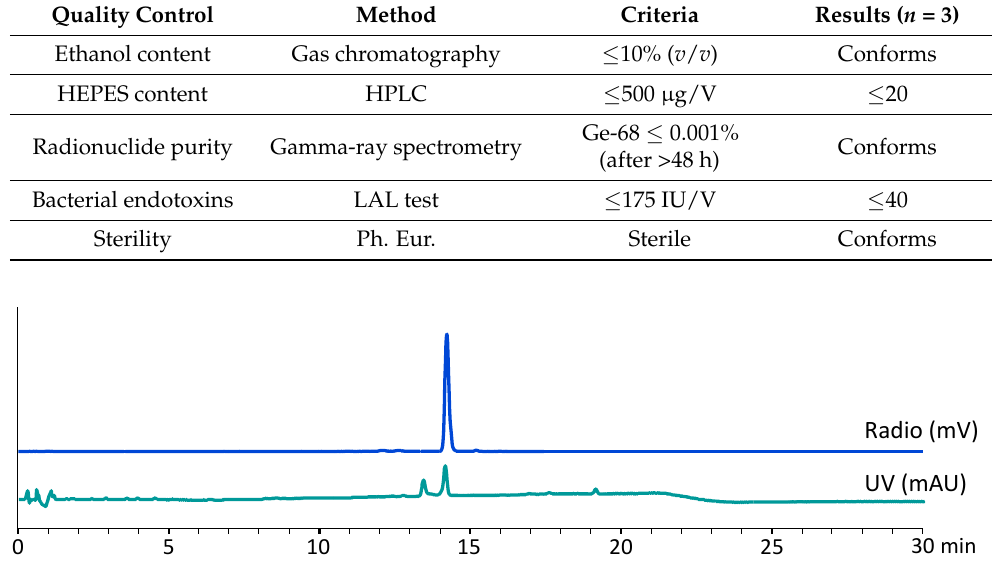
Table 2. Post-release analyses of three batches of [ 68 Ga]Ga-DOTA-MGS8.